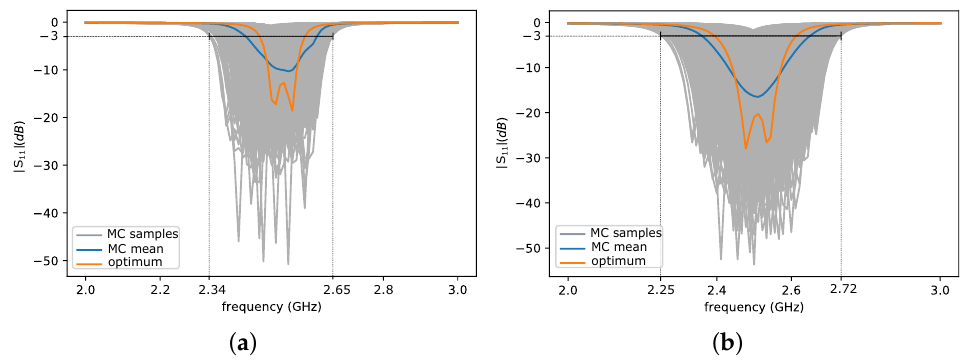
Figure 9. ( a ) Return loss | S 11 | of the zigzag bandpass filter using robust BO and ( b ) standard BO. ( a ) The optimal 3 dB bandwidth by the robust BO is [2.47, 2.58] GHz. MC analysis reveals, however, that it may extend up to [2.34, 2.65] GHz. ( b ) The optimal 3 dB bandwidth by the standard BO is [2.40, 2.61] GHz. MC analysis reveals, however, that it may extend up to [2.25, 2.72]